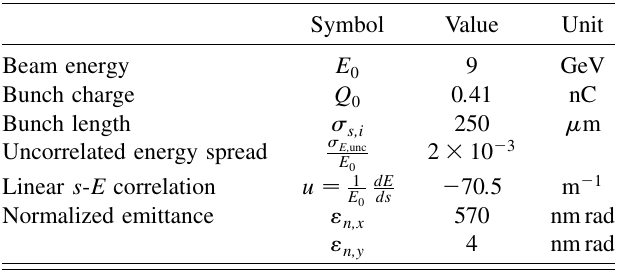
TABLE II. Parameters of the electron bunch in front of the bunch compressor